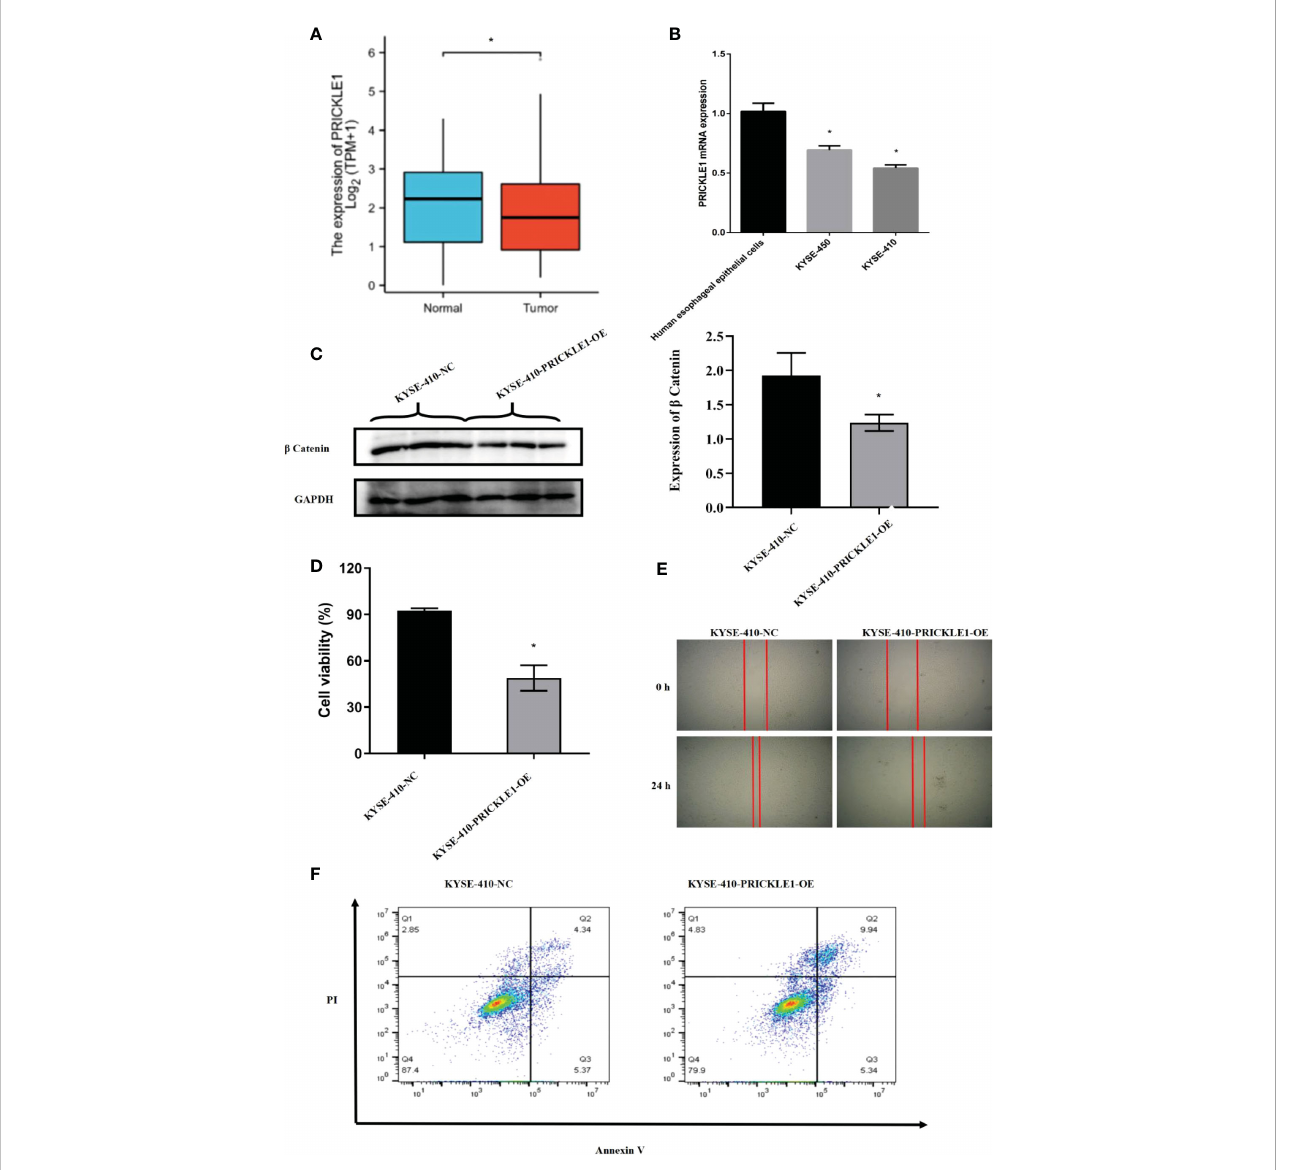
FIGURE 5 Experimental validation (A) Expression of PRICKLE1 in normal human esophageal epithelial cells and esophageal cancer cells; (B) qPCR showing mRNA expression in normal human esophageal epithelial cells and esophageal cancer cells; (C) WB showing the activation level of Wnt/b-catenin signaling pathway in NC group and PRICKLE1-OE group; (D) CCK8 showing cell viability in NC group and PRICKLE1-OE group; (E) Cell scratch assay showing cell migration in the NC group and PRICKLE1-OE groups; (F) Flow cytometry showing apoptosis in the NC group and PRICKLE1-OE groups, with the sum of cells in Q2 and Q3 in the NC group being 9.71% and the sum of cells in Q2 and Q3 in the PRICKLE1-OE group being 15.28%. Compared with the Human esophageal epithelial cells group, *P<0.05; Compared with the NC group,